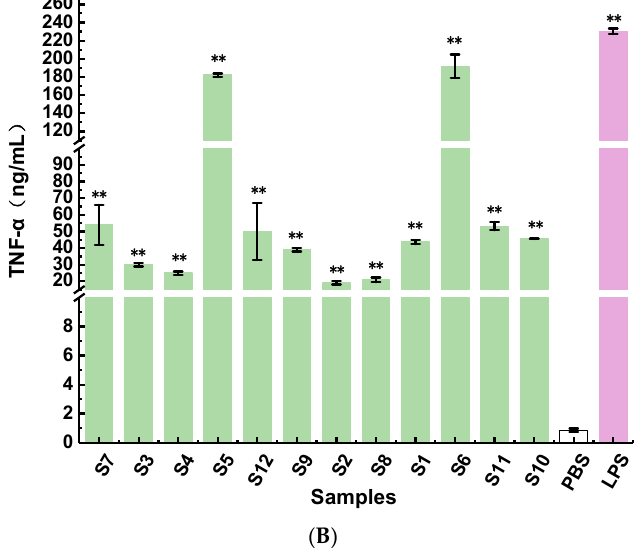
Figure 5. Effects of polysaccharide fractions on NO release ( A ) and TNF- α secretion ( B ) from RAW264.7 cells. ** indicates a significant difference between samples and negative control at p < 0.01.